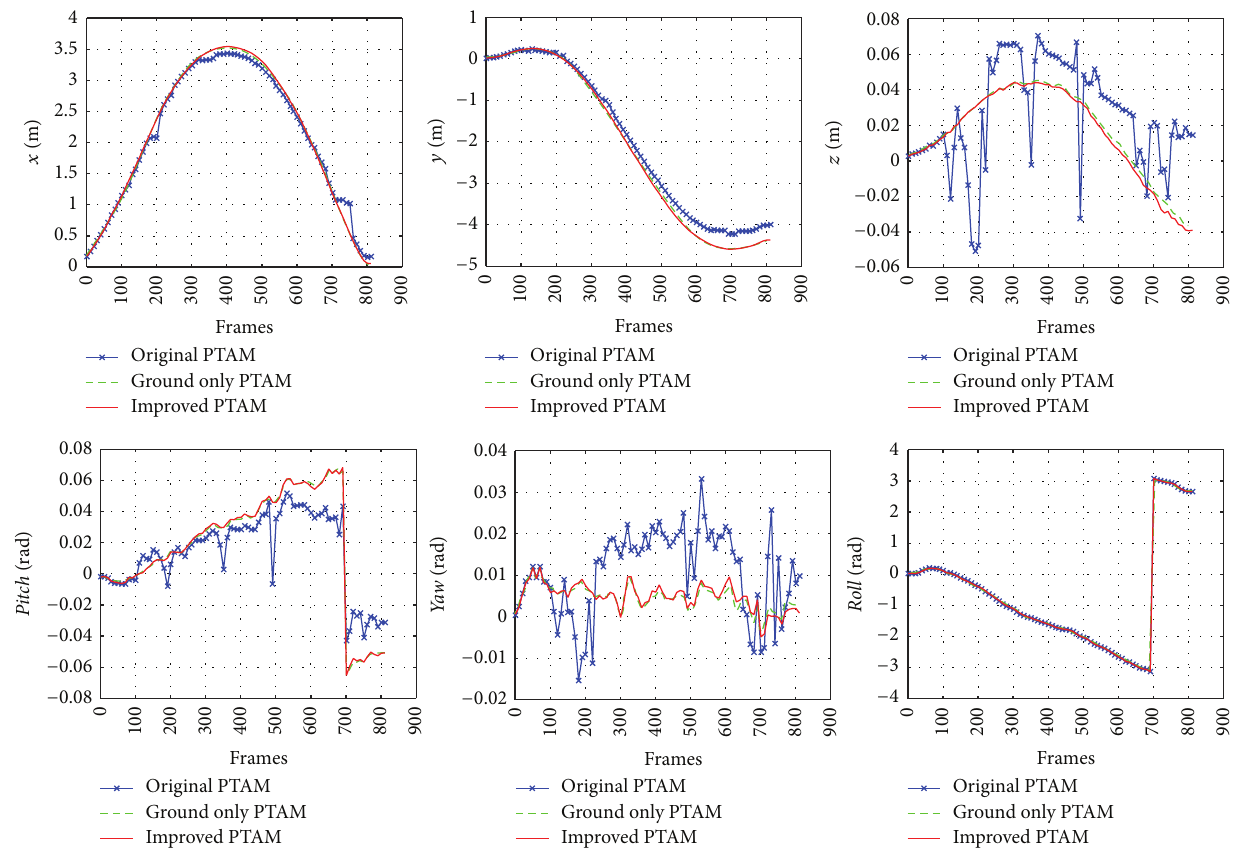
Figure 8: The compare result among the original PTAM, ground only PTAM, and our proposed algorithm.